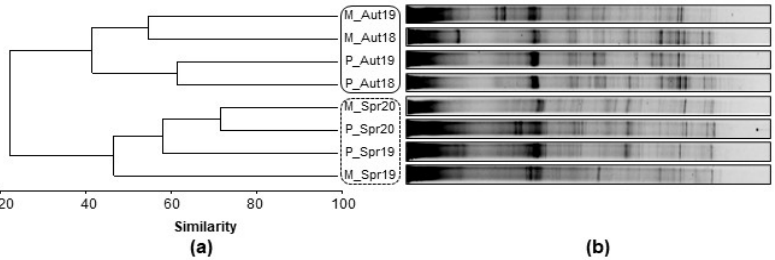
Figure 2. ( a ) Complete linkage dendrogram and ( b ) PCR-DGGE fingerprints of the bacterioplankton found at each sampling site (Miranda—M; Pocinho—P) and sampling period (Aut18; Spr19; Aut19; Spr20).